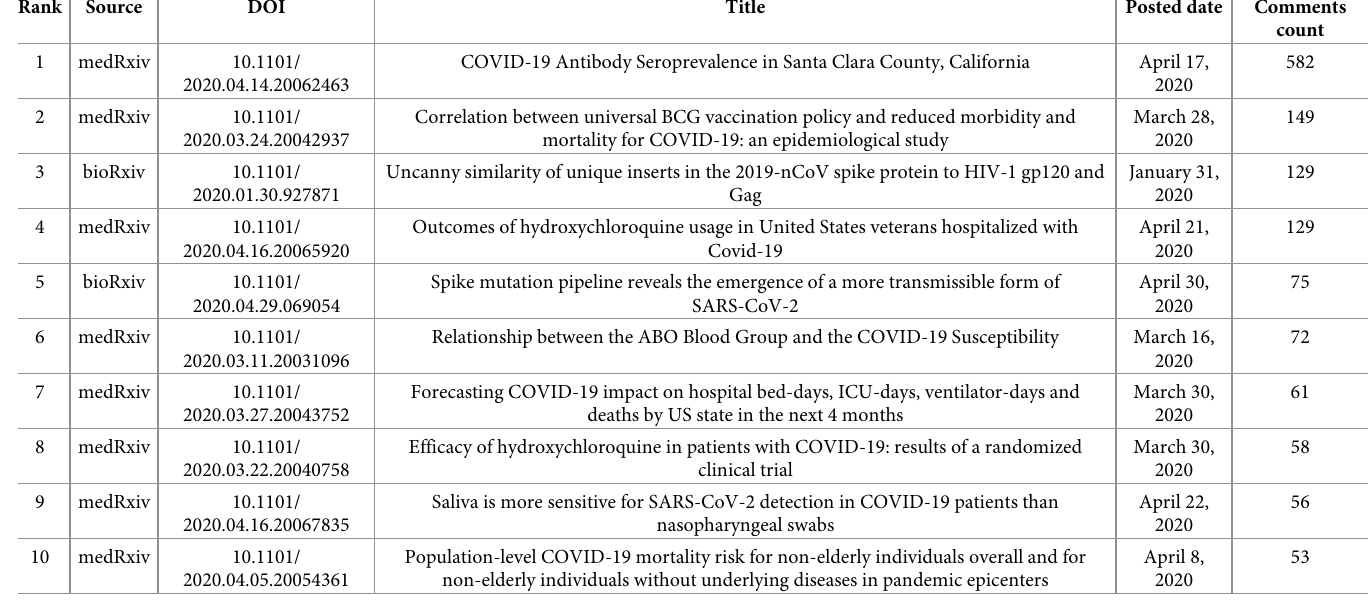
Table 4. Top 10 commented on COVID-19